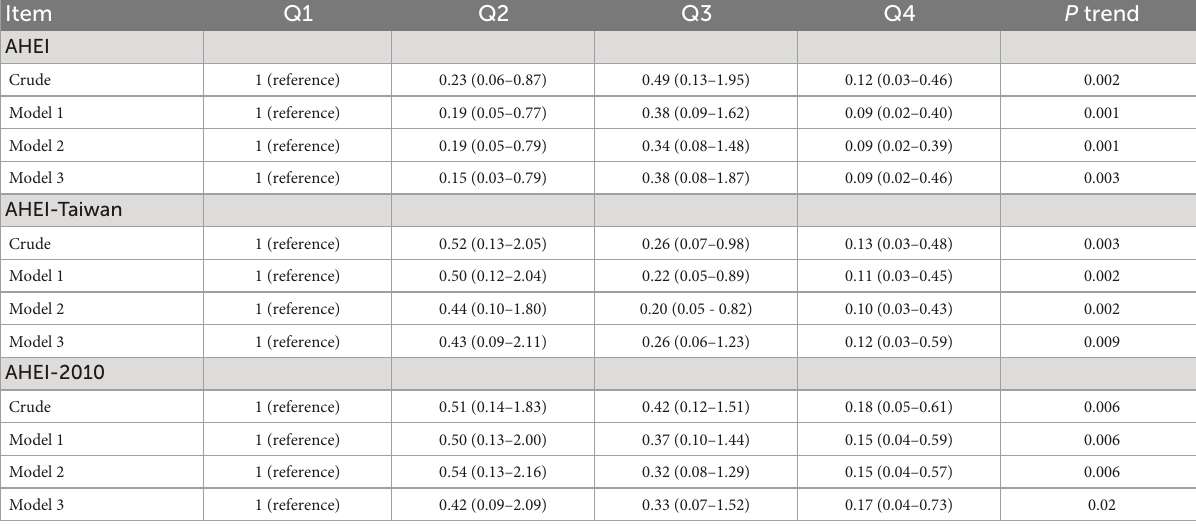
TABLE 4 Risk of incident chronic kidney disease by the AHEI, AHEI-Taiwan, and AHEI-2010 in the renal transplant recipients 1 .